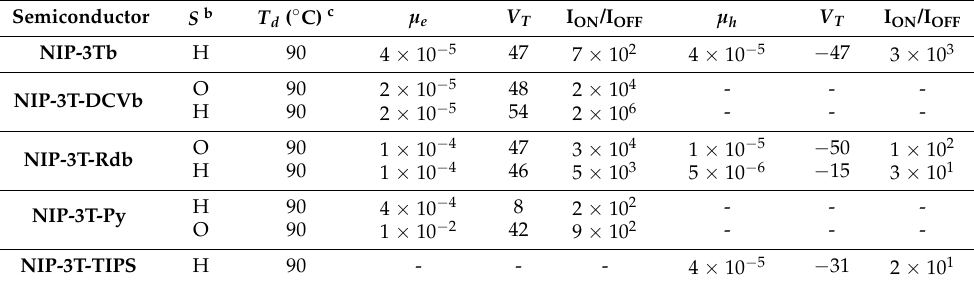
Table 11. OFET electrical data for vapor-deposited films of NIP-3Tb , NIP-3T-DCVb , NIP-3T-Rdb , NIP-3T-Py and NIP-3T-TIPS measured under vacuum on vapor-treated Si/SiO 2 substrates. Average field-effect mobilities are shown a